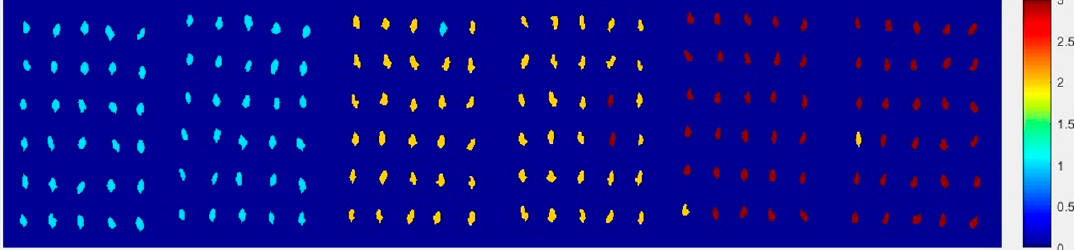
Figure 12. The final visualization images of Haihe78 with the SPA and PLS-DA model with method M2P.